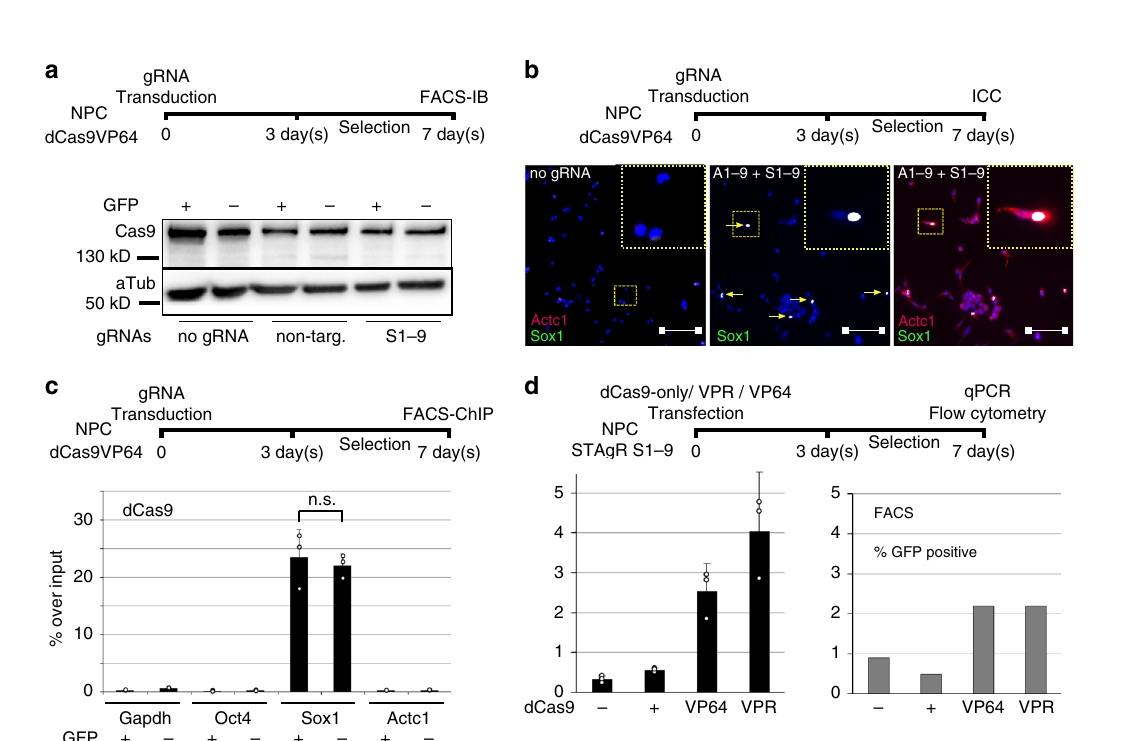
Fig. 2 Phenotypic consequences of Sox1 induction. a Sox1 GFP induction can endure prolonged time periods. Sox1 GFP positive cells were FACS sorted from control (no gRNA) and experimental settings (SoxProm), cultured for 7 more days and eventually analyzed by fl ow cytometry. While Sox1 GFP -positive cells sorted from control populations show no relative enrichment, those from the activated population show a strong increase of the number of cells in the GFP- positive gate after 7 days, indicating some steadiness of the gene induction. b , c Sox1 activates hundreds of genes associated with a stem cell identity. b Heat map showing the 100 genes most signi fi cantly induced by Sox1 induction (NPC + ). Most of these genes are also higher in the transcriptomes of early neural stem cells (NSCs, 7 days neural induction of ESCs; NR, sorted neural rosette cells). c Relative expression changes of a selected set of genes are shown; data shown as (logarithmic) fold change and standard error of the mean; all data are depicted for three individual biological replicates. d , e Differentiation assays reveal changes in the potency of Sox1-positive NPCs. After gRNA transduction, Sox1 GFP -positive and -negative cells were sorted from both control (no gRNA) and activated (S1-9) populations and differentiated for 7 days; d scale bars (upper row: 20 µ m; lower row: 100 µ m). e The number of cells positive for the neuronal marker TujI increased signi fi cantly in Sox1-positive cells (*** p < 0.001 in two-sided Student ’ s t -test; n = 3 biological replicates, generated independently on different days in different clonal lines)